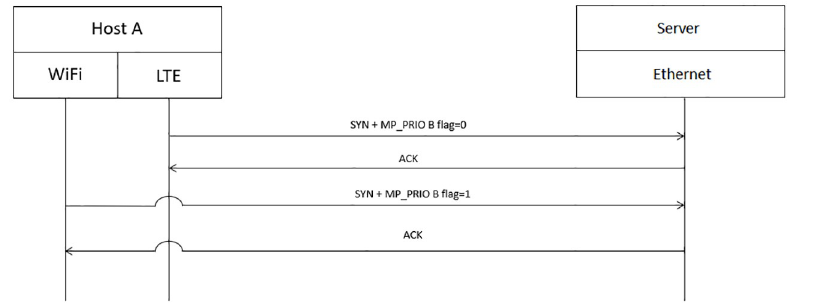
Fig 19. Use of the cellular network as the primary network path.